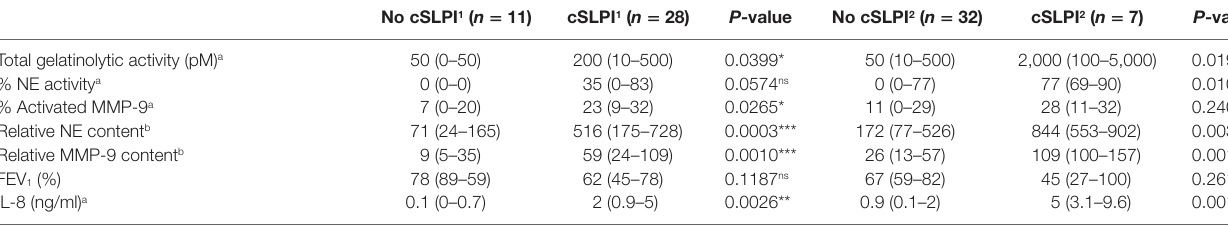
TaBle 2 | Detailed analysis of lower airway secretion from patients with non-cystic fibrosis bronchiectasis.